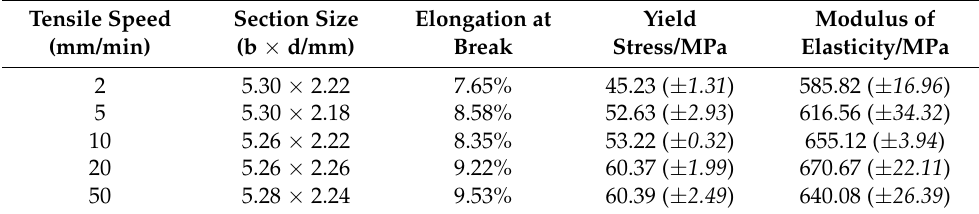
Table 7. Quasi-static tensile test data of PLA-Cu.